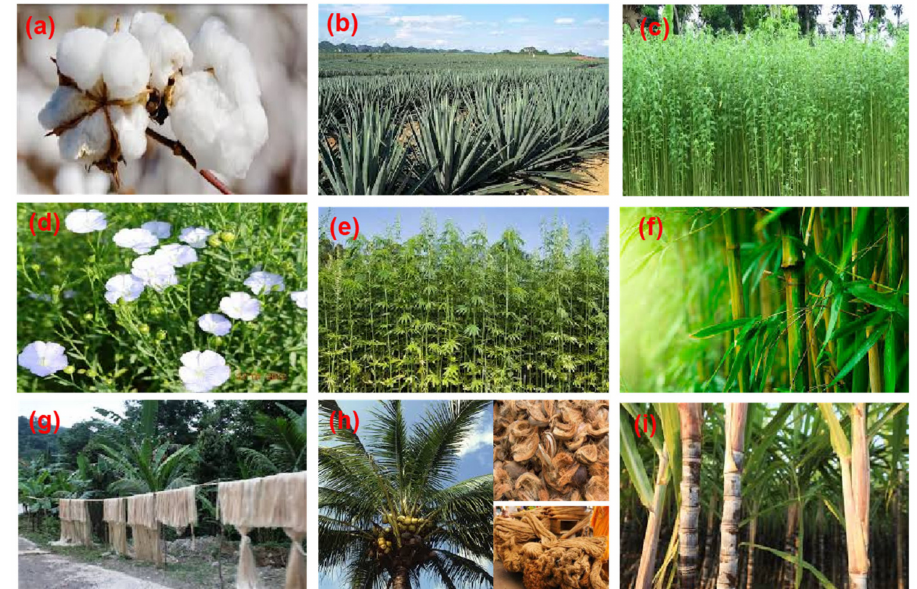
Figure 3. Natural fibre plants: ( a ) cotton; ( b ) sisal; ( c ) jute; ( d ) flax; ( e ) hemp; ( f ) bamboo; ( g ) banana; ( h ) coir; ( i ) sugar